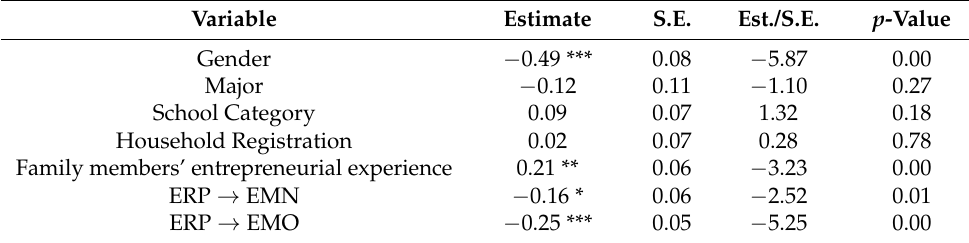
Table 4. Direct Effect Result.